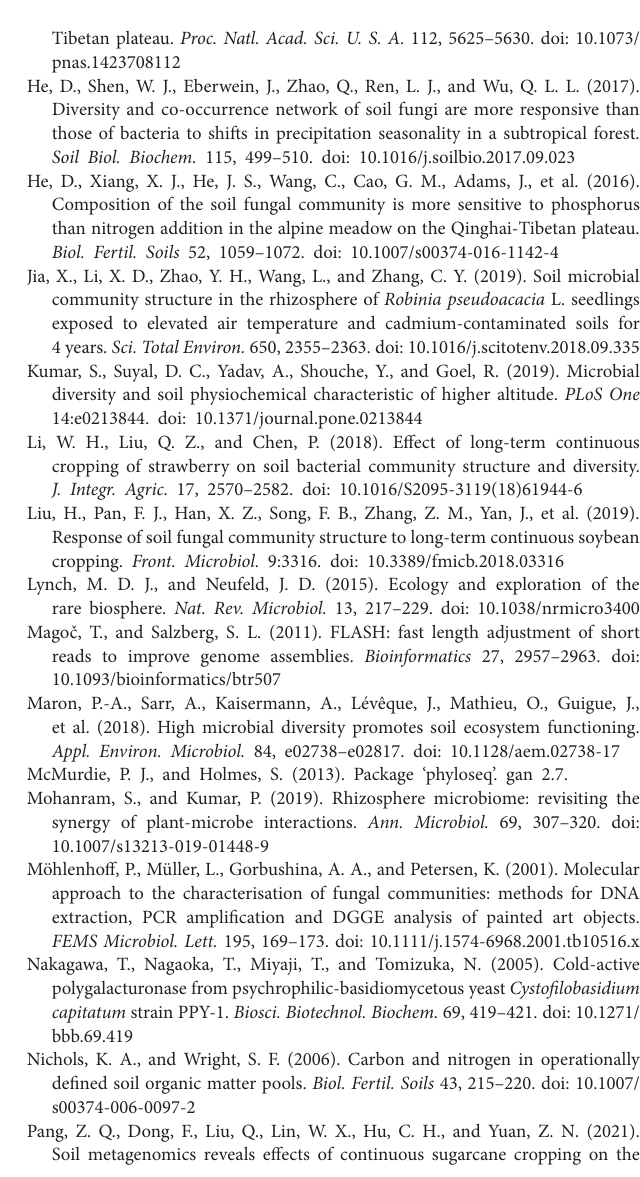
Supplementary Figure S1 | Relative abundance of fungal phyla in the rhizosphere soil of Tibetan barley continuously cropped for different durations. Values represent means ± SD ( n = 4). Different lowercase letters within the same column indicate significant differences among different continuous cropping durations at p < 0.05 according to a two-way ANOVA. Supplementary Figure S2 | Co-occurrence networks show the correlations among total fungal OTUs in CC2Y (A) , CC3Y (B) , CC4Y (C) , CC5Y (D) , and CC6Y (E) . A connection indicates a strong (| r | of ≥ 0.8) and significant ( p of ≤ 0.01) Spearman’s correlation. Red lines indicate positive correlations, while green lines indicate negative correlations. The network is colored by a module that clusters the tightly connected